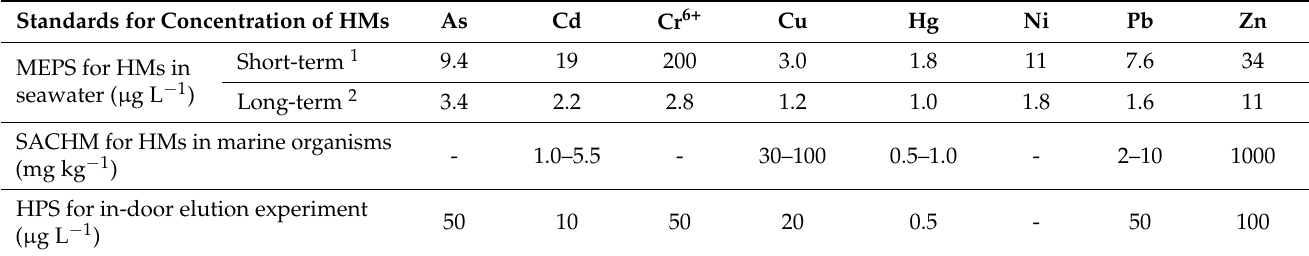
Table 1. Location and depth of sites for control and experiment.